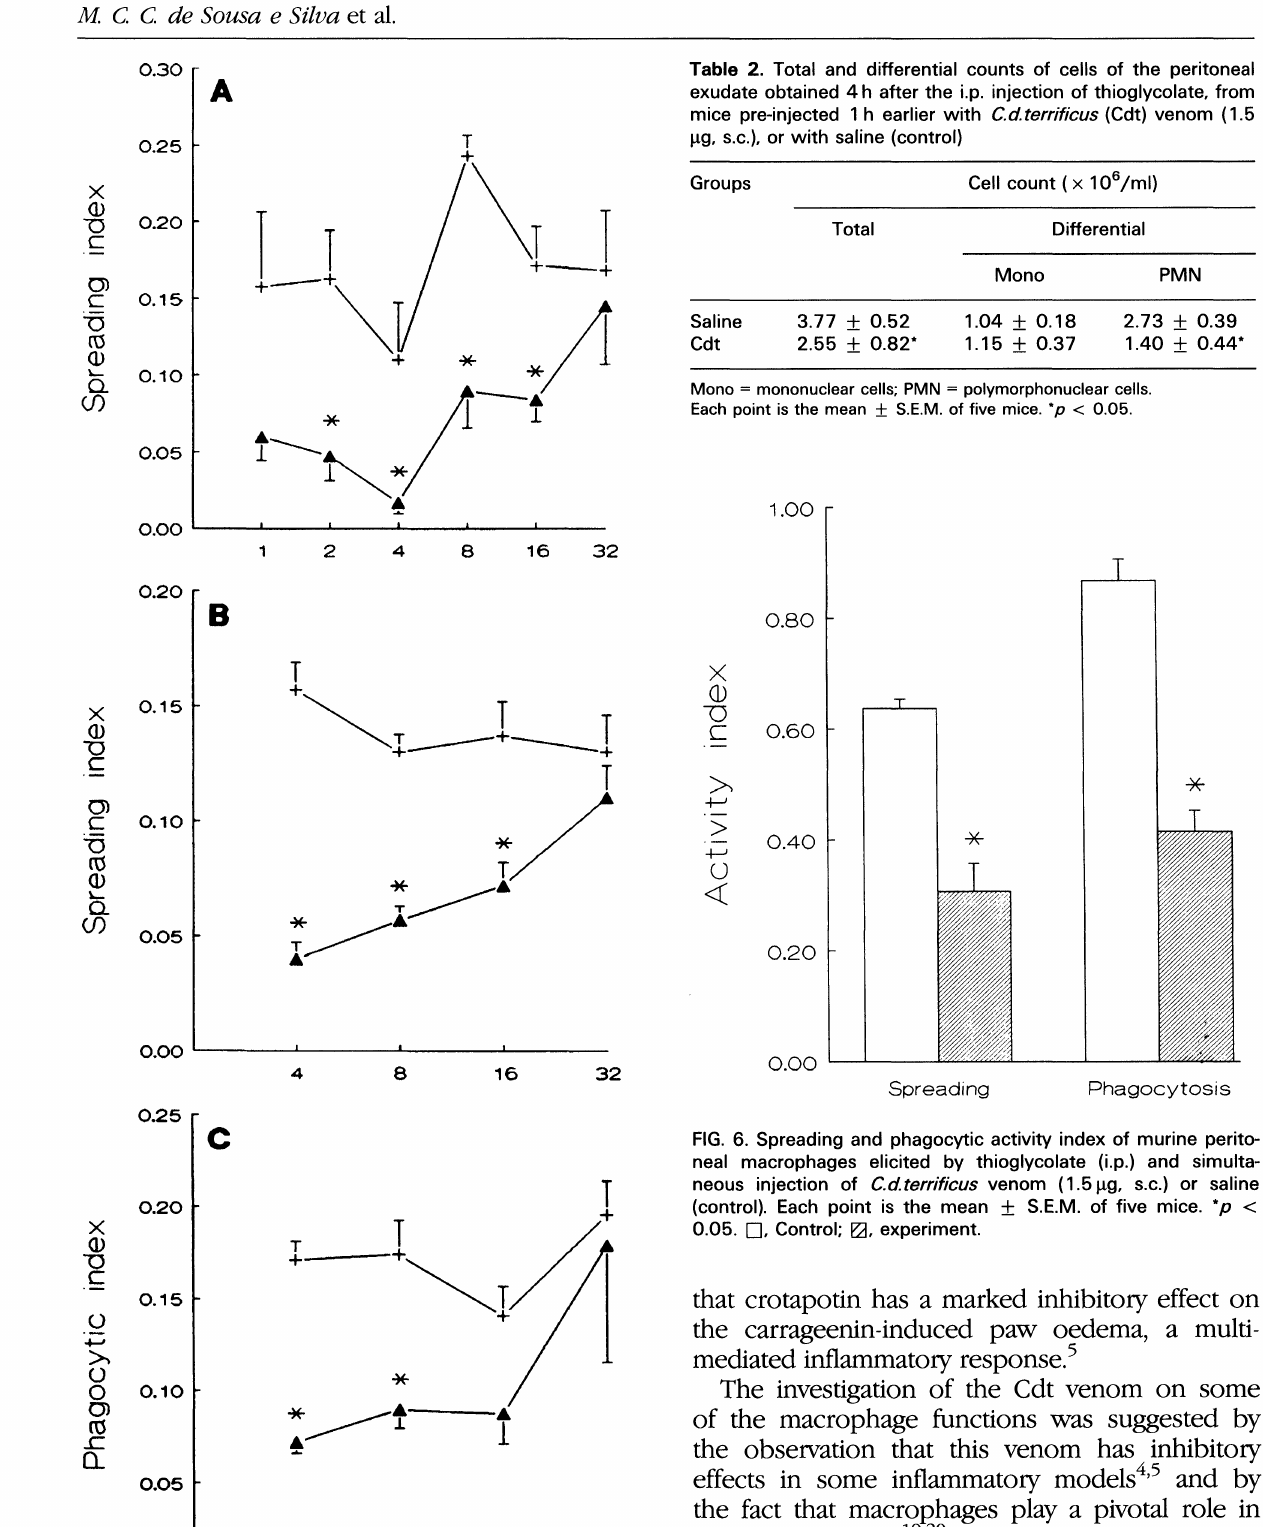
Table 2. Total and differential counts of cells of the peritoneal exudate obtained 4 h after the i.p. injection of thioglycolate, from